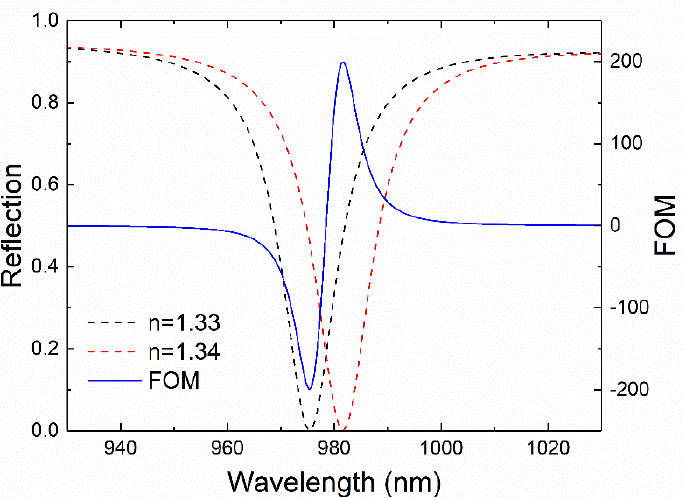
Figure 6. Reflection peak corresponding to the SLR at the test layer–Au interface for a test layer of 600 nm in thickness with values of the refractive index of 1.33 (black dashed line) and 1.34 (red dashed line). The blue solid line corresponds to the computed 𝐹𝑂𝑀 from these two spectra using Equation (2).